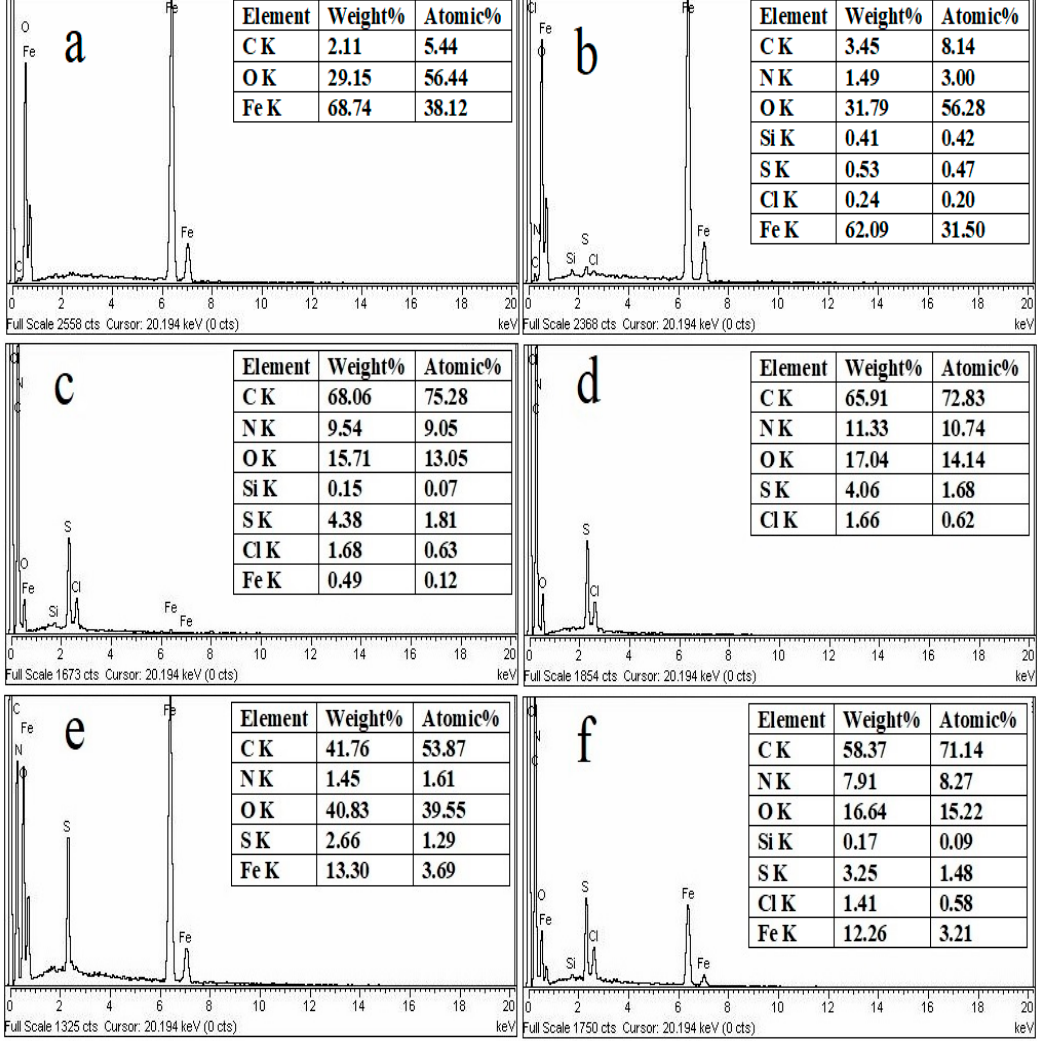
Figure 3. EDX spectra of Fe 3 O 4 , PANI and PANI / Fe 3 O 4 composites before ( a , c , e ) and after ( b , d , f ) adsorption of AB40.